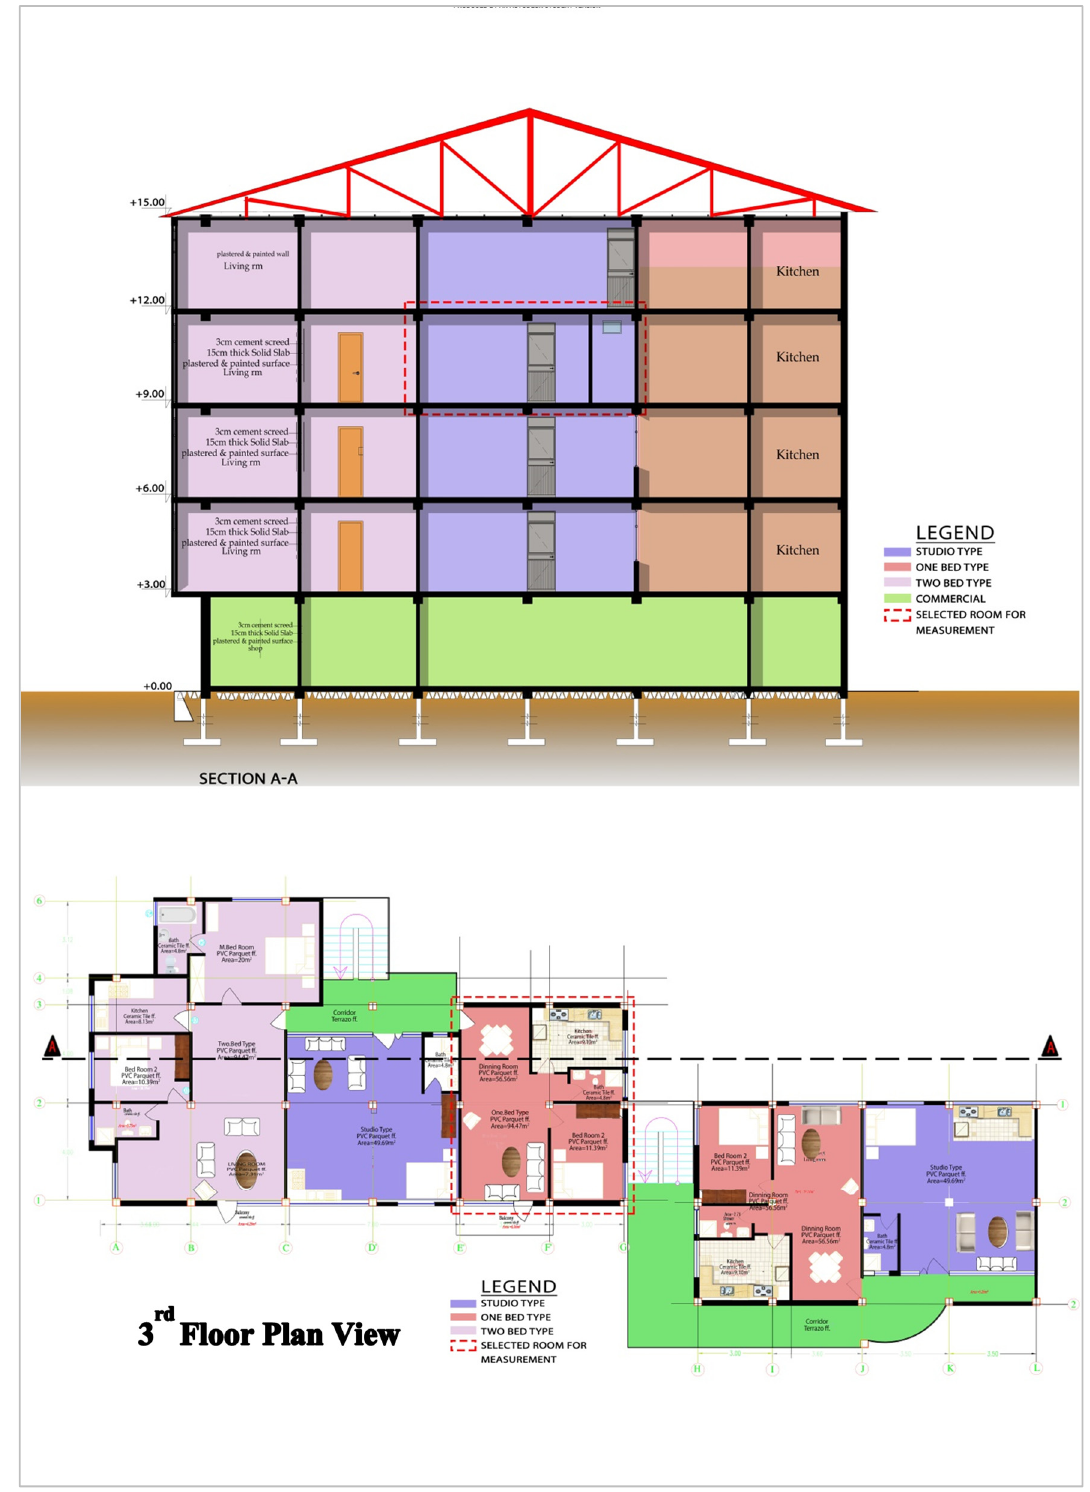
Figure 15. Typical floor plan of a condominium block.